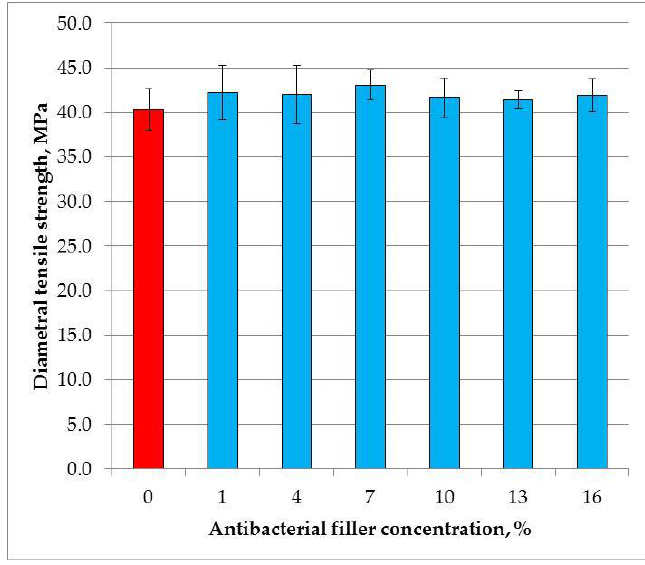
Figure 4. Mean values and standard deviations of diametral tensile strength.